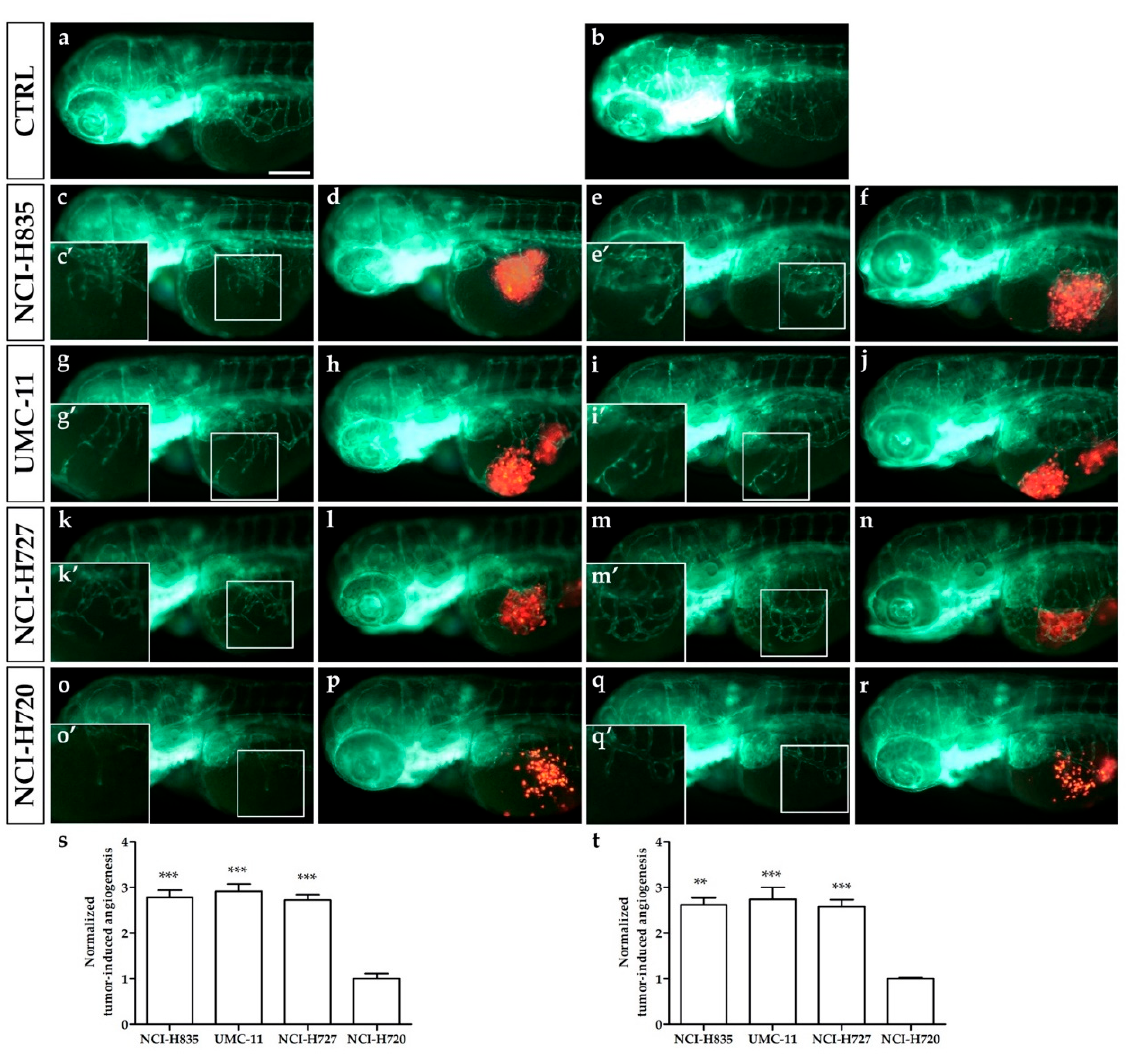
Figure 1. Engraftment of lung carcinoid cells in zebrafish embryos. Representative epifluorescence images of Tg(fli1a:EGFP) y1 embryos injected with cell resuspension solution (control: a , b ) and implanted with red-stained NCI-H835, UMC-11, NCI-H727, and NCI-H720 cells ( c – r ). Embryos were imaged at 24 ( a , c , d , g , h , k , l , o , p ) and 48 ( b , e , f , i , j , m , n , q , r ) hpi. The red channel was omitted in panels ( c , e , g , i , k , m , o , q ) to facilitate the observation of tumor-induced angiogenesis (green). ( c ’, e ’, g ’, i ’, k ’, m ’, o ’, q ’) are the digital magnifications of white-boxed regions. The graphs showed the quantification of tumor-induced angiogenesis in embryos implanted with lung carcinoid cells after 24 ( s ) and 48 ( t ) hpi. NCI-H720 values have been set to 1.0. Graphed values represent the mean ± S.E.M. ** p < 0.01 vs. NCI-H720; *** p < 0.001 vs. NCI-H720. All implanted cells stimulated endothelial sprouting from the SIV plexus within 24 hpi. Embryos are shown anterior to the left. Scale bar: 100 µm.